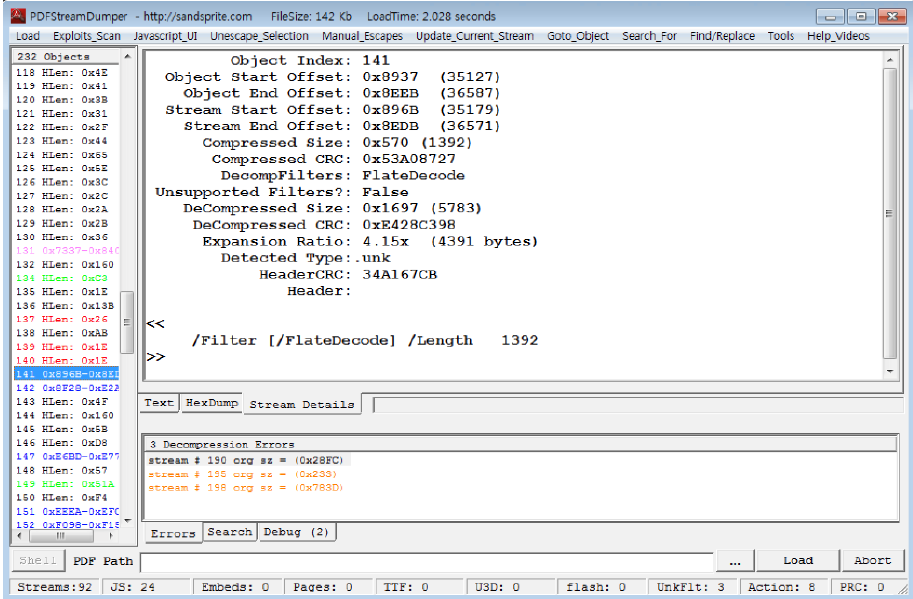
Figure 5. A benign PDF file opened by PDFStreamDumper.